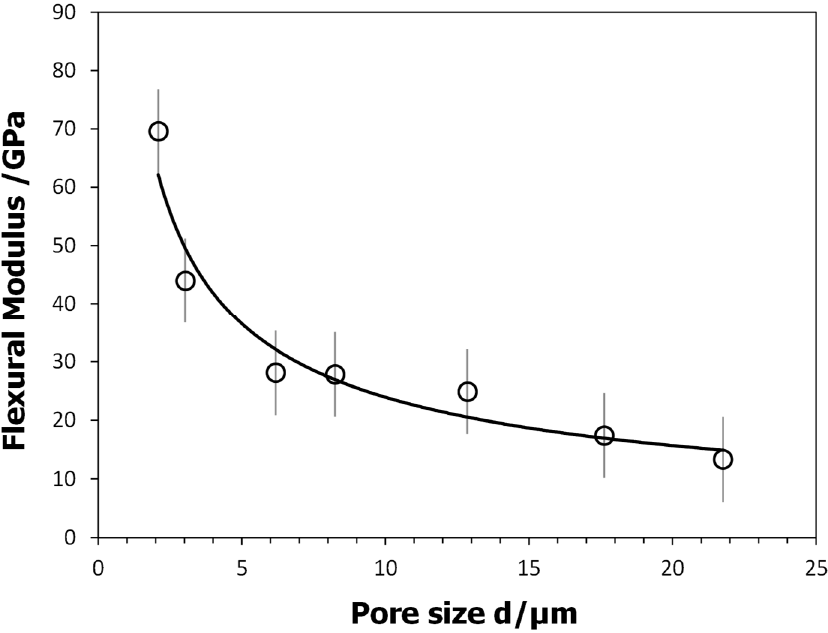
Figure 6. Relation curves between the flexural modulus and the average pore size for porous Ti 3 SiC 2 .